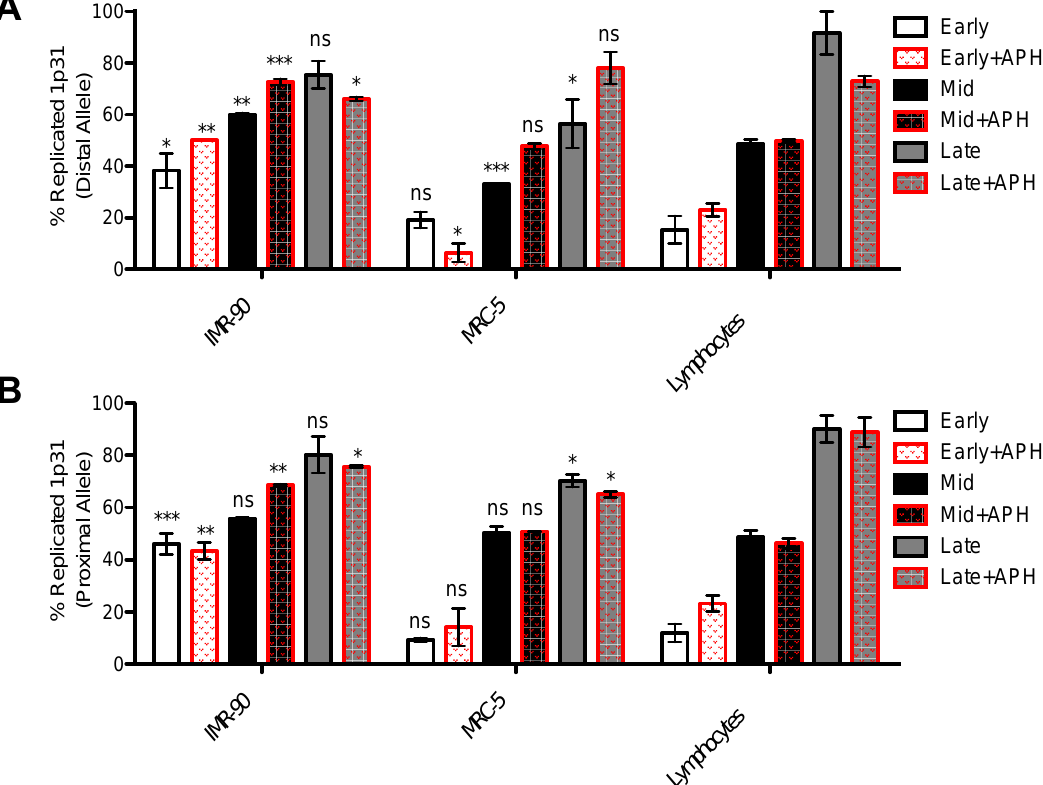
Figure 5. Replication timing analysis of 1p31.1 fragile region on fibroblasts and lymphocytes. The histograms show the percentage of replicated alleles in MRC-5 and IMR-90 cell lines under normal and stressful condition (addition of aphidicolin (APH)). The replication timing of lymphocytes was used as a control. Percentage of replicated distal ( A ) and proximal ( B ) probes are shown. Mean of three individual experiments is plotted, with error bars representing the standard error of the mean (SEM). p- values were calculated on the basis of differences between each condition in fibroblasts with the corresponding treatment in lymphocytes. ns: non-significant; * for p ≤ 0.05, ** for p ≤ 0.01, and *** for p ≤ 0.001.